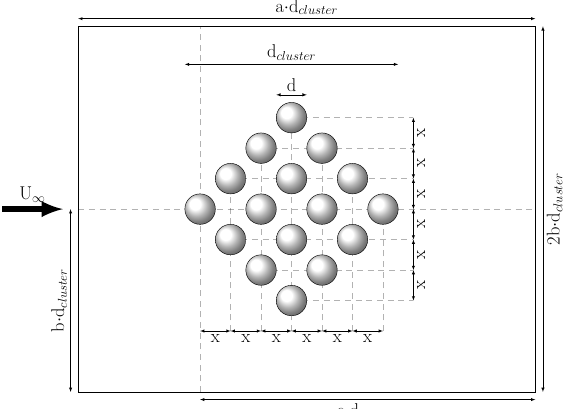
Figure 2. Horizontal cross-section of the synthetic particle cluster. 2 particle centers, which is varied to obtain clusters with different void fraction. Cuts through all Cartesian axis planes look identical. The scaling factors of the simulation domain are a = 12, b = 3.75, c =